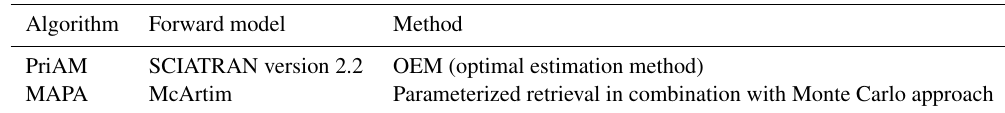
Table 2. List of retrieval algorithms used in the comparison. Algorithm Forward